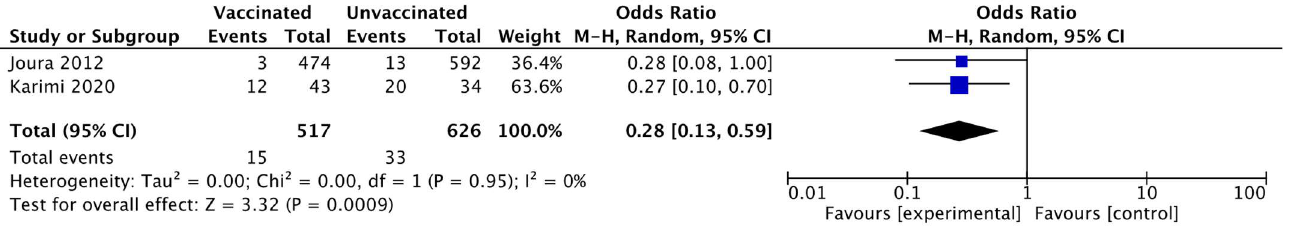
Figure 7. Forest plot of comparison: CIN 3+ recurrence.